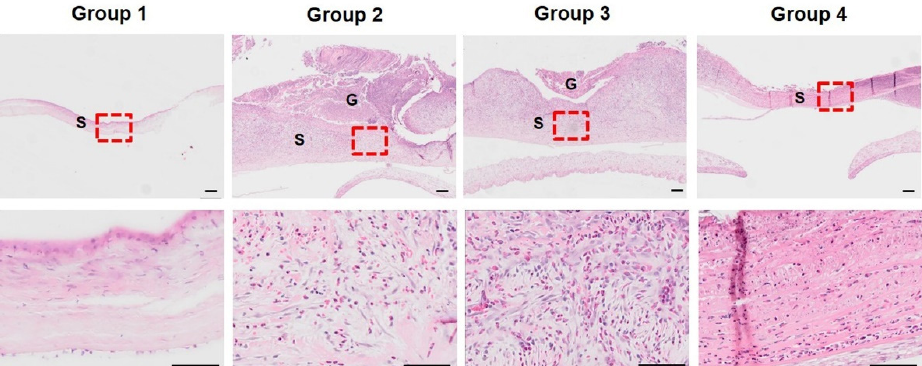
Figure 5. H&E staining of the cornea three weeks after surgery. No inflammatory cells were observed in group 1. Thickened stromal layer and diffuse existence of fibroblasts and neutrophils were presented in groups 2 and 3. The stroma thickness of group 4 is relatively thin compared to groups 2 and 3, and fibroblasts are rarely seen. The area marked with a red square in the 20× magnification was observed at 200x magnification. G = graft, S = stroma, Scale bar (black line) = 100 µm.